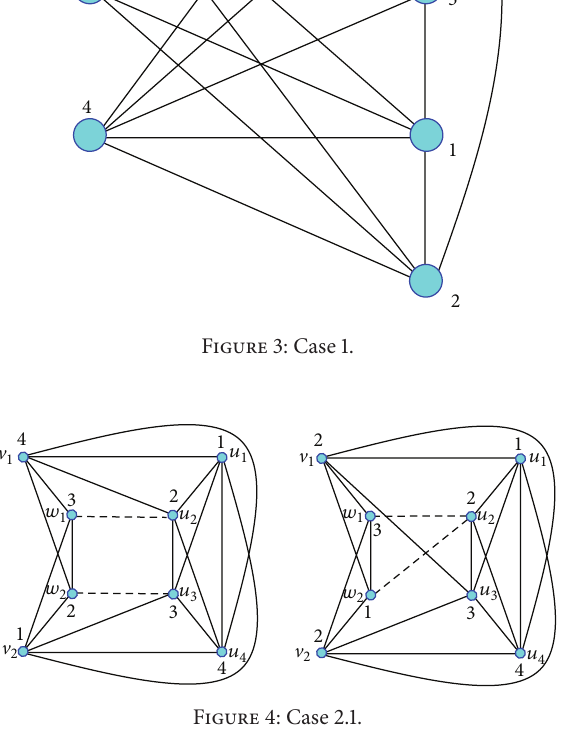
Figure 4: Case 2.1.